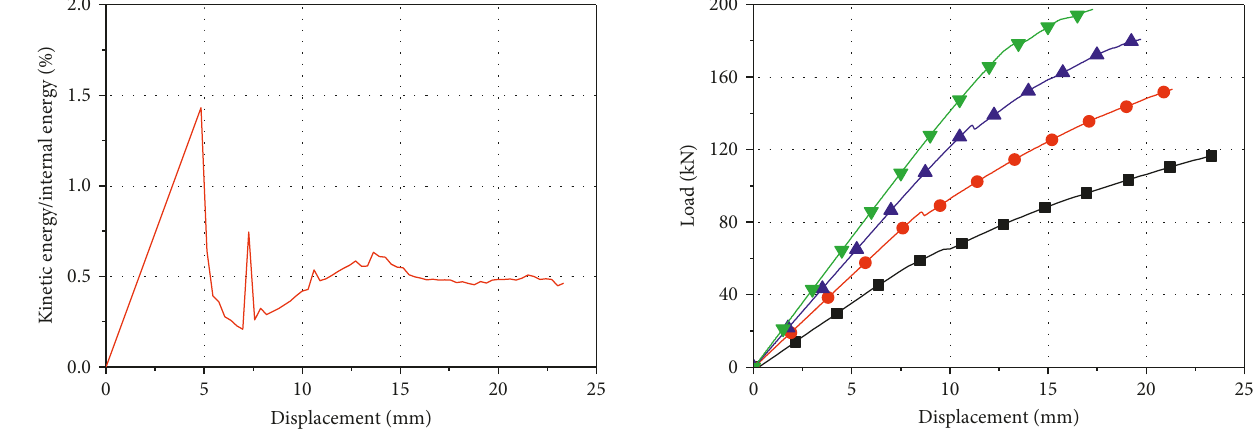
100mm, s (cid:30) (cid:30)